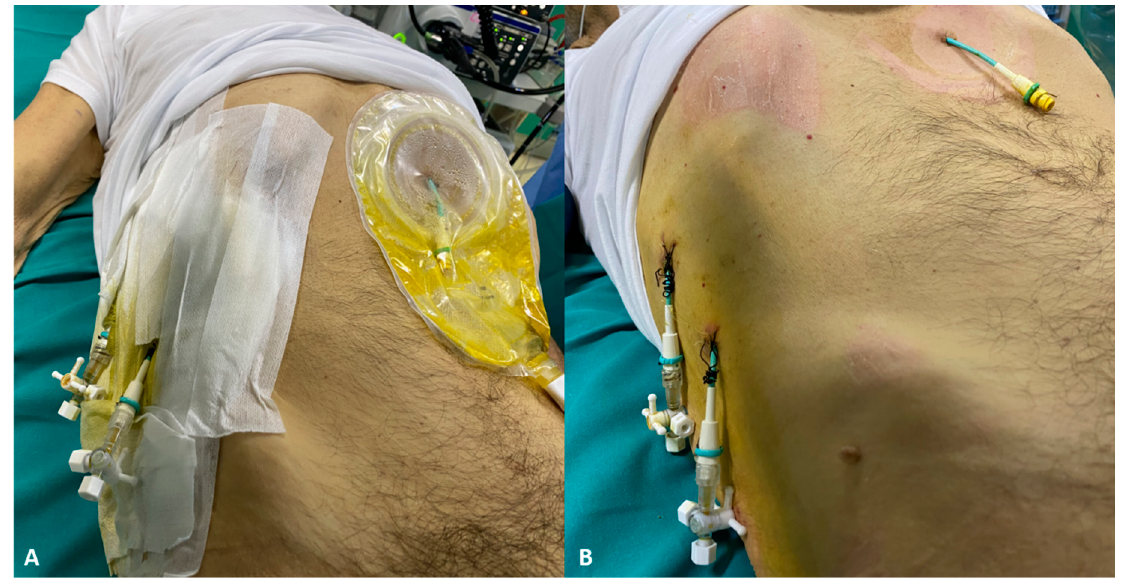
Figure 4. Three percutaneous drainages in a patient with hilar cholangiocarcinoma. ( A ) Bile spillage from the drainages ( B ) with skin erythema.